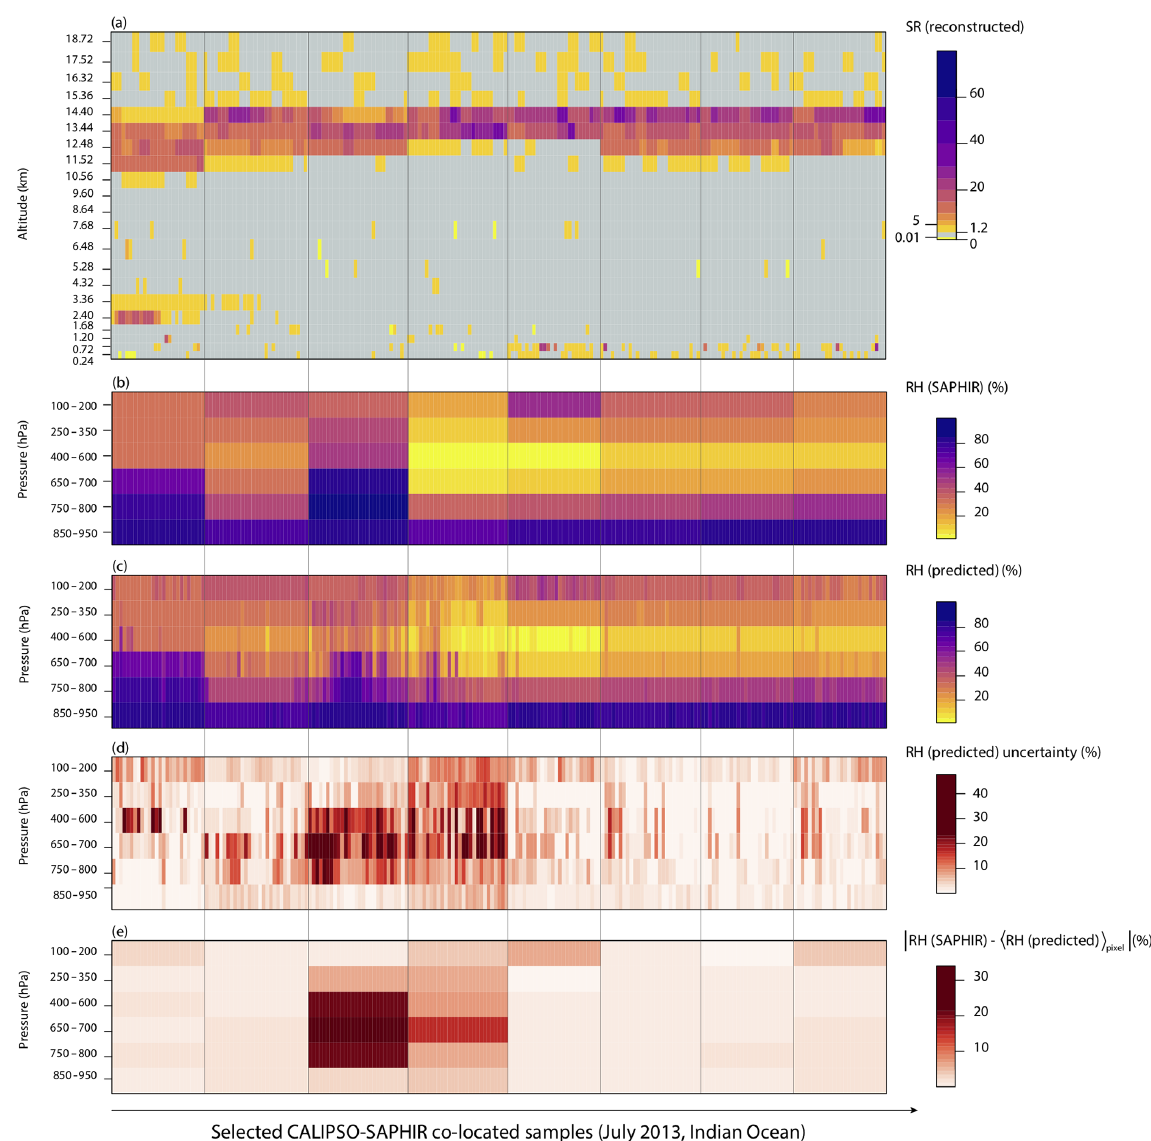
Figure 8. (a) : SR profiles for a selection of ice cloud profiles from CALIPSO in the Indian Ocean, July 2013. The selected cloud profiles correspond to SAPHIR pixels with n ( M ) > 25. The scale is the same as in Fig. 2. (b) : co-located layered-RH observations from SAPHIR (mean). (c) : predicted layered RH using the QRF method within the iterative scheme (median). (d) : as (c) but for the interquartile range instead of the median. (e) : for each layer, absolute differences between the observed RH from SAPHIR and the average over each SAPHIR pixel of the predicted RH. The x axis represents the co-location